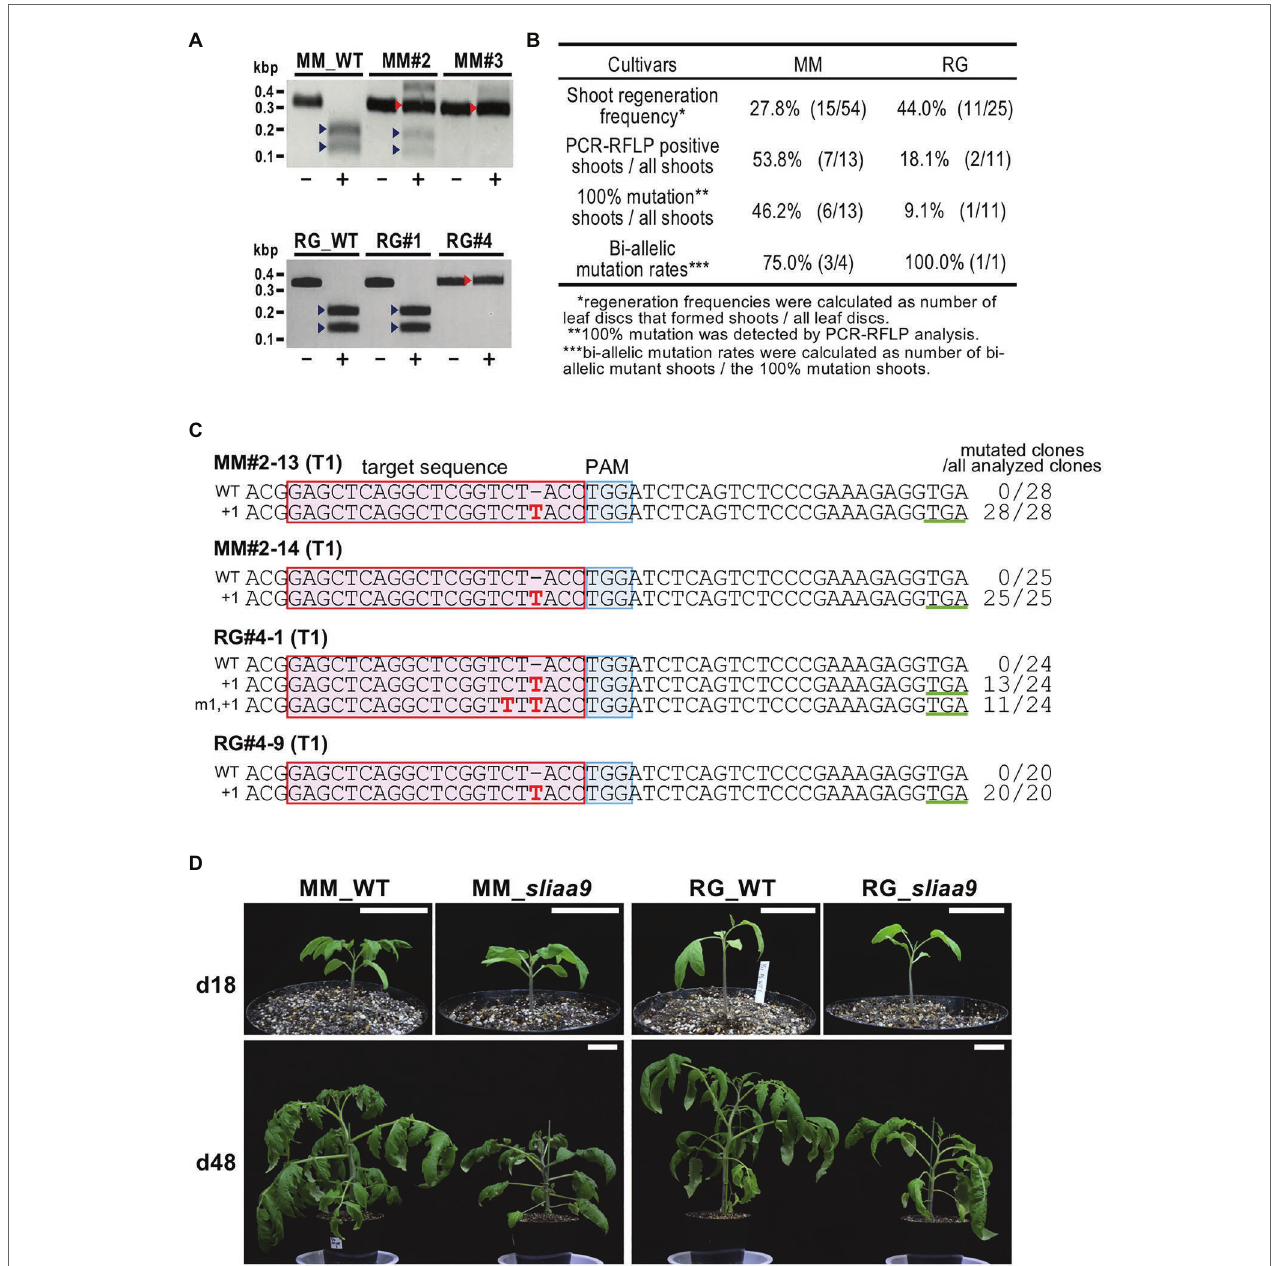
FIGURE 1 | Isolation of sliaa9 Knockout Mutants in Various Tomato Cultivars. (A) PCR-RFLP analysis of SlIAA9 in CRISPR-Cas9 transgenic T0 lines (MM#2, MM#3, RG#1, and RG#4). Target sites in the SlIAA9 gene were amplified by PCR using total DNA isolated from T0 shoots of cultivars Moneymaker and Rio Grande. PCR products were digested with Acc I, which has a recognition site at the CRISPR-Cas9 target site. MM; Moneymaker, RG; Rio Grande, − ; untreated, +; treated with Acc I, red arrowheads; mutated bands, blue arrowheads; wild-type fragments digested with Acc I. (B) Mutation efficiency in regenerated shoots (T0). (C) SlIAA9 mutation sequences in sliaa9 T1 lines (MM#2-13, MM#2-14, RG#4-1, and RG#4-9) were analyzed by Sanger sequencing. MM; Moneymaker, RG; Rio Grande, red box; target sequence, blue box; PAM sequence, green underline; newly generated stop codon following CRISPR-Cas9 editing, red characters; and mutated nucleotides. The wild-type (WT) sequences are on top in each alignment. The numbers on the left of the sequences indicate mutated nucleotides. The number of clones analyzed is shown to the right of the sequences. (D) Wild-type and the representative sliaa9 T2 lines 18 days and 48 days after germination. The plants were grown under low light conditions. Left; MM (Moneymaker; T2 line, MM#2-13-4), right; RG (Rio Grande; T2 line, RG#4-1-6). Bars = 5